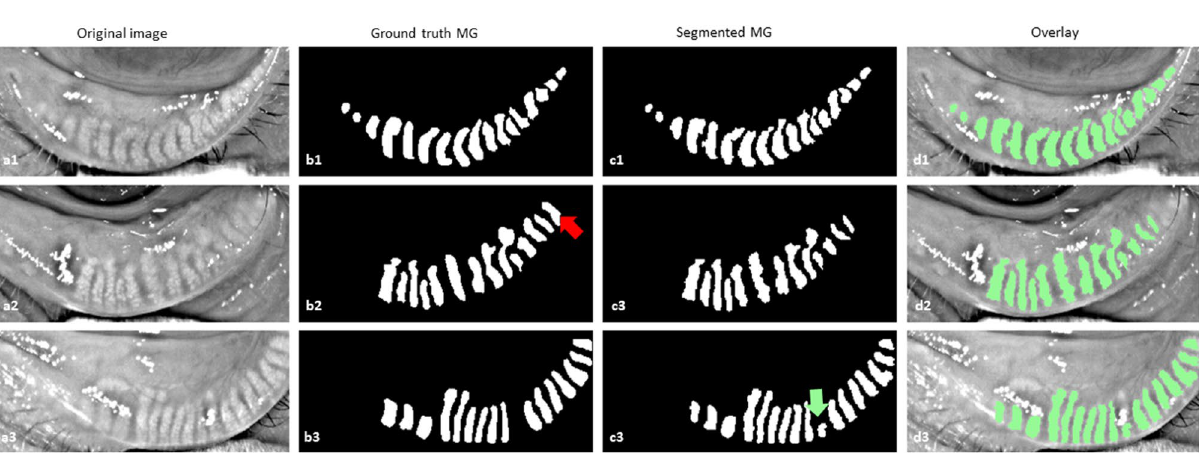
Figure 4. Example of MG segmentation from lower eyelid on test images. ( a1 – a3 ) original images, ( b1 – b3 ) ground truth MG, ( c1 – c3 ) Segmented MG, and ( d1 – d3 ) overlay of the original image and segmented MG. The red ( b2 ) and green ( c3 ) arrows indicate the missing gland and false gland segmentation